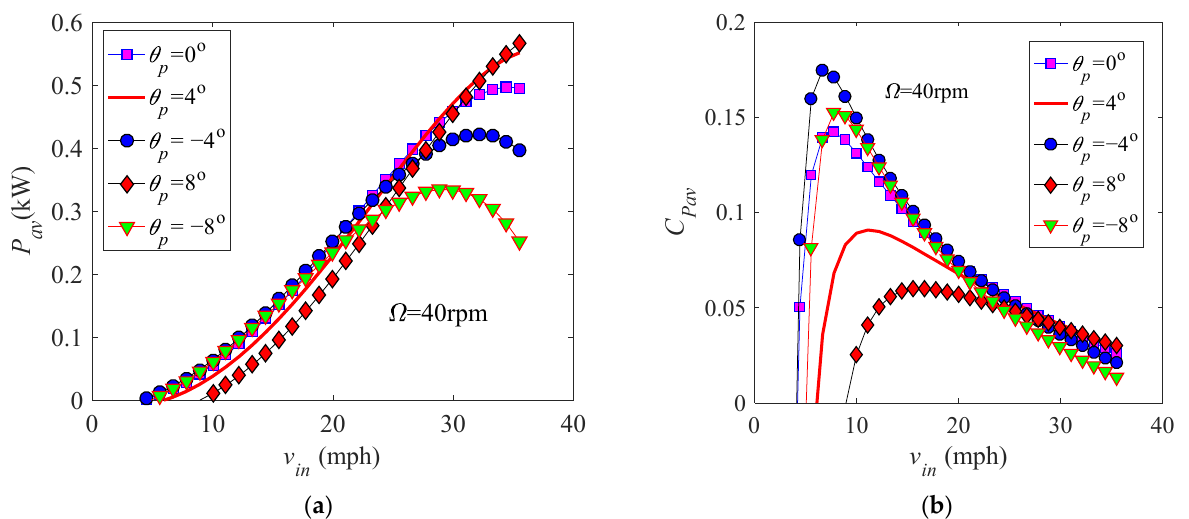
Energies 2021 , 14 , x FOR PEER REVIEW Figure 15. Variations of ( a ) the power and ( b ) power coefficient with the incoming wind speed for the fixed Ω = 40 rpm.